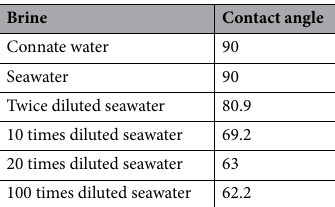
Table 10. Reported contact angle by Yousef et al. 51